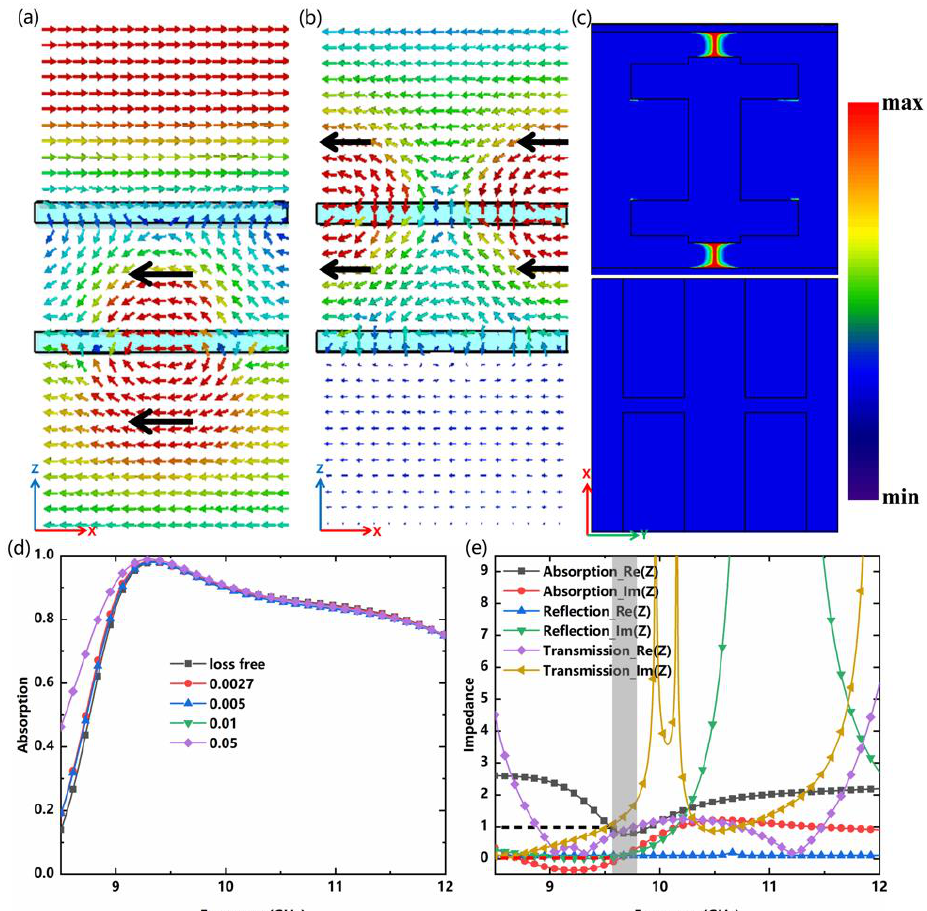
Figure 3. The x-z plane electric field distribution at 9.702 GHz of ( a ) Transmission mode; and ( b ) Reflection mode; ( c ) The power loss density distribution of part A and part B at 9.702 GHz; ( d ) The absorption corresponding to the dielectric with different loss tangents; ( e ) Real and imaginary parts of the complex impedance